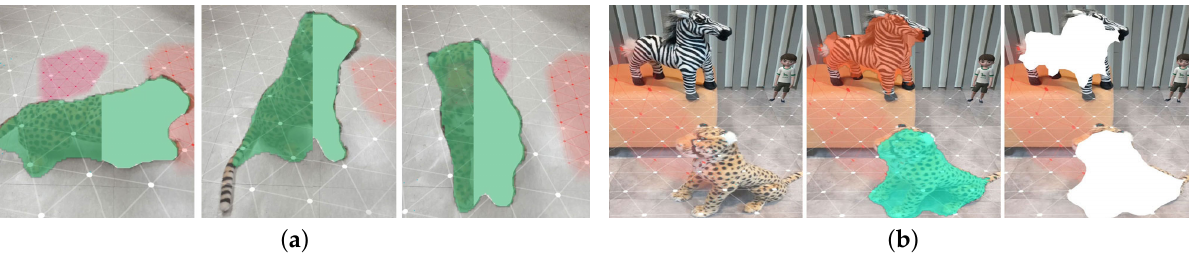
Figure 6. Photo illustrations of our silhouette meshes generated from a single camera feed. Our proposed method is robust even in various orientation and deformable object ( a ), as well as in the complex background ( b